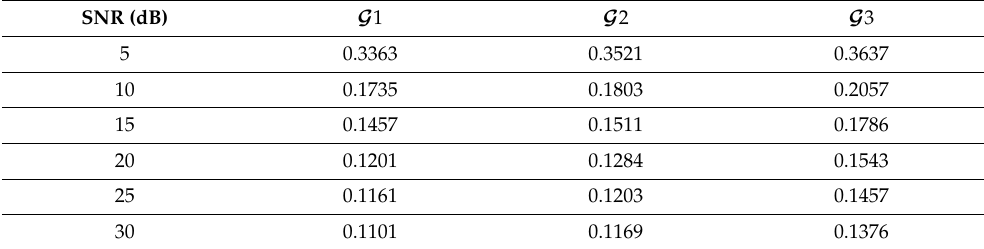
Table 1. RMSE versus SNR under different graphs with T 60 = 200 ms.